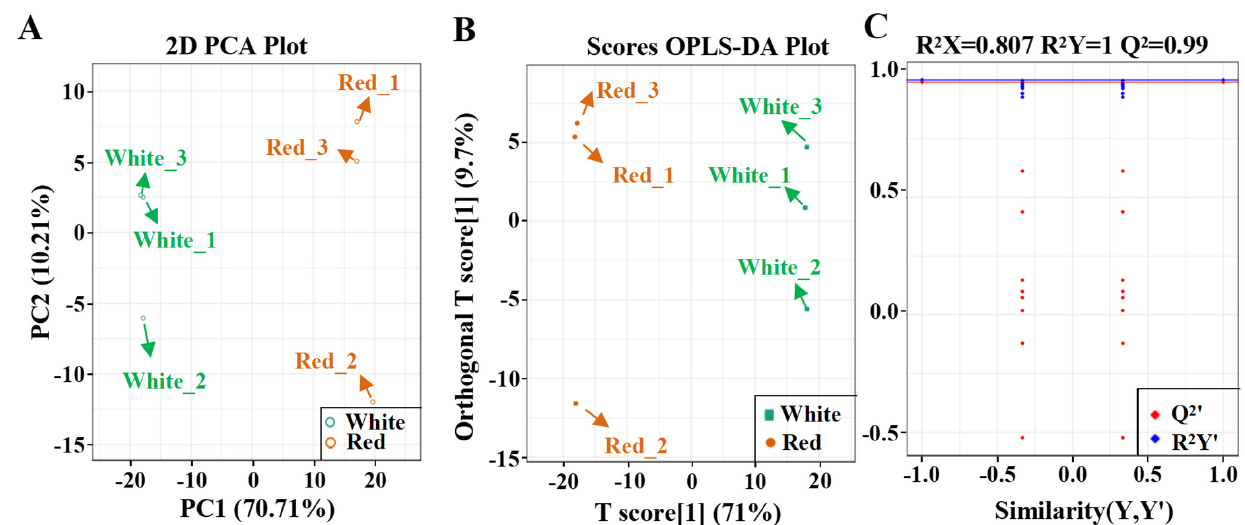
Figure 2. PCA and OPLS-DA on metabolites of pomelo fruit. ( A ) PCA score plot. ( B ) OPLS–DA score plot. ( C ) OPLS–DA permutation analysis model validation graph.